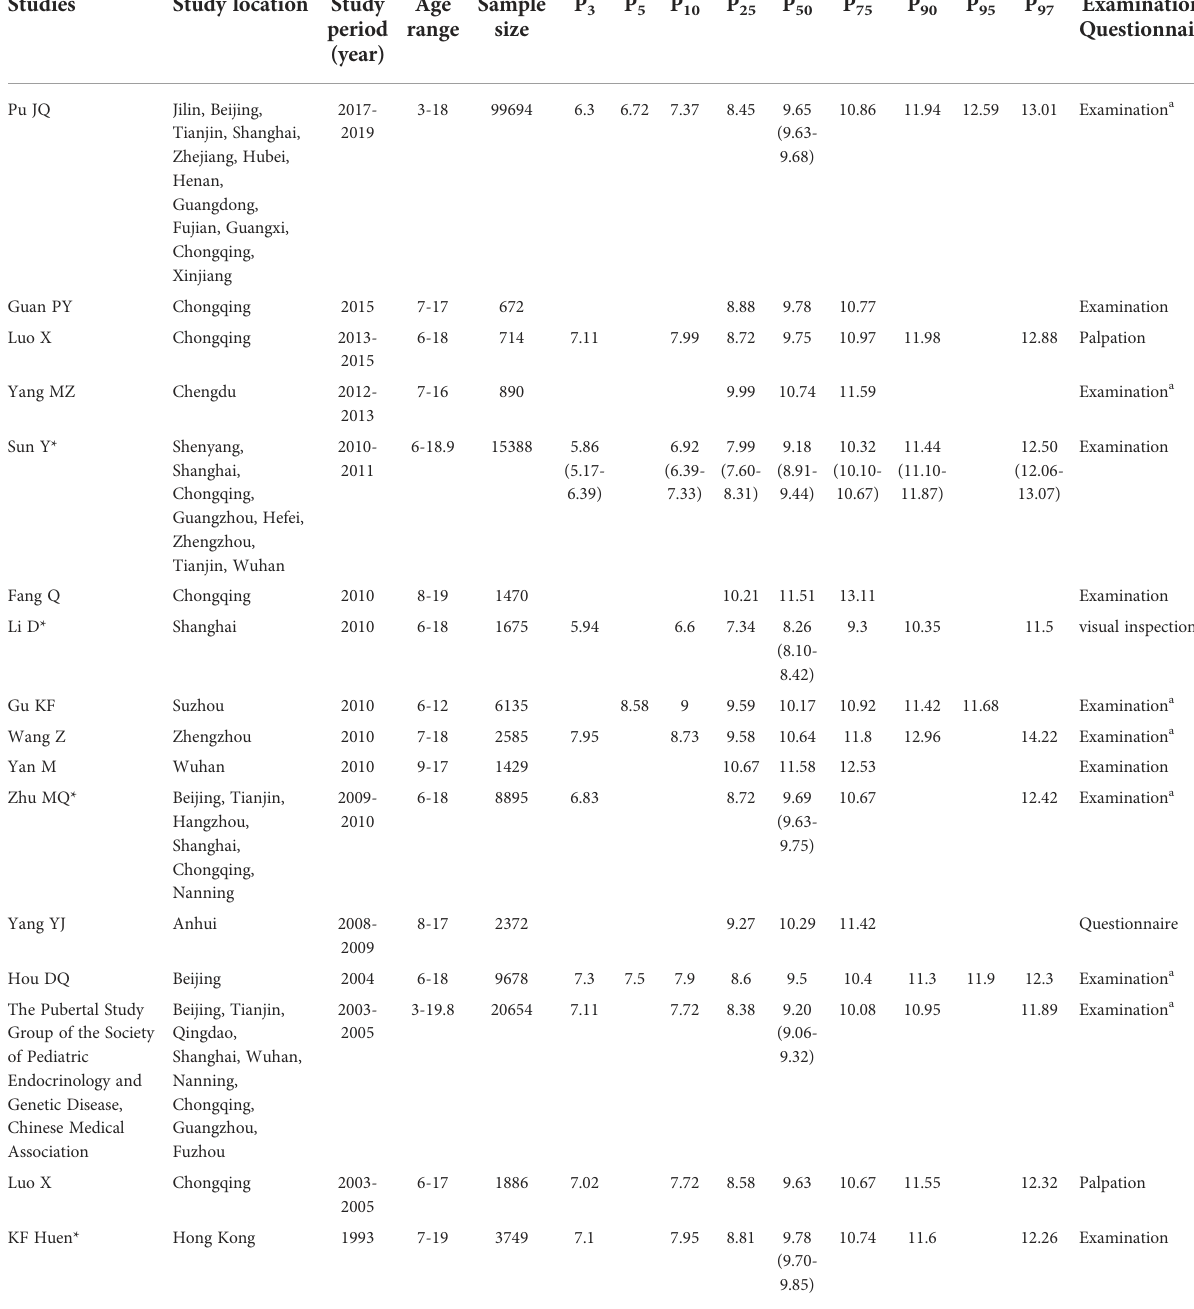
TABLE 2 Characteristics of the included